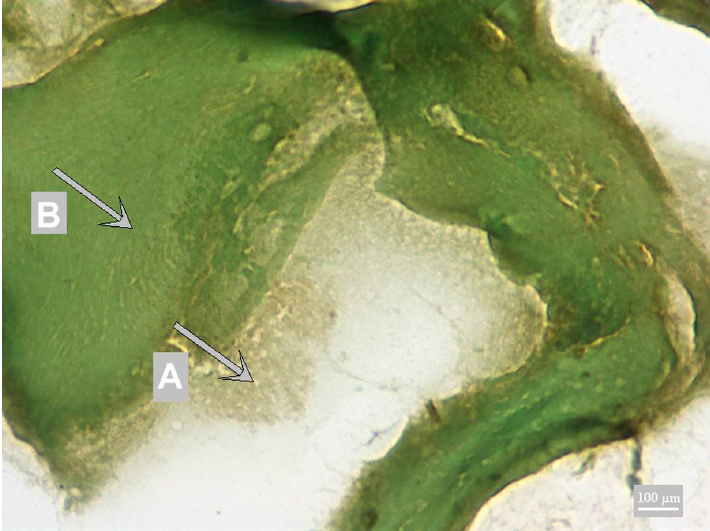
Figure 1. Calleja staining with DAB chromogen; A chromogen precipitate—calcium caseinate (gray-brown); B muscle fiber (green). The combination with Toluidine Blue achieved a different color spectrum of the background (Figure 2).